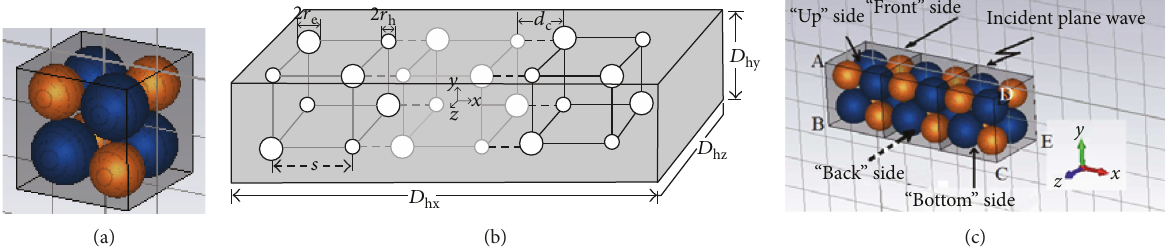
Figure 4: Τ he medium designed to behave as DNG material around 2GHz. (a) The unit cell of 8 particles. (b) The con fi guration of “ Lattice B ” composed of 3 adjacent cells, s = 6 34 mm , r e = 3 75mm , r h = 2 56mm , d c = 1 mm , total lattice size=43.34mm × 13.78mm × 13.78mm, and size of lattice plus host: D hx = 44 34mm , D hy = 14 78mm , and D hz = 17 78 mm . (c) the 3D pattern of the Lattice B.